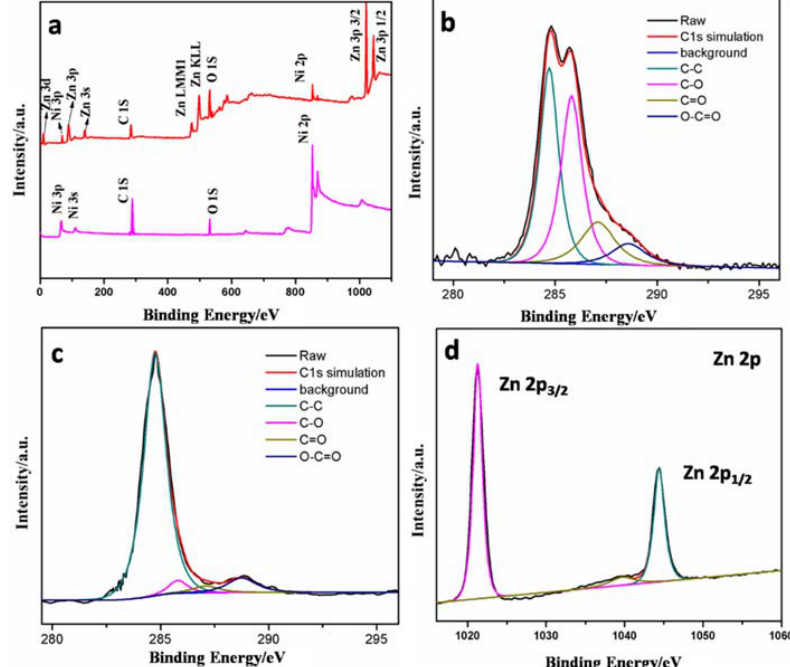
Figure 3. ( a ) X-ray photoelectron spectroscopy(XPS) survey spectra of GO/NF and ZnO/RGO@NF;